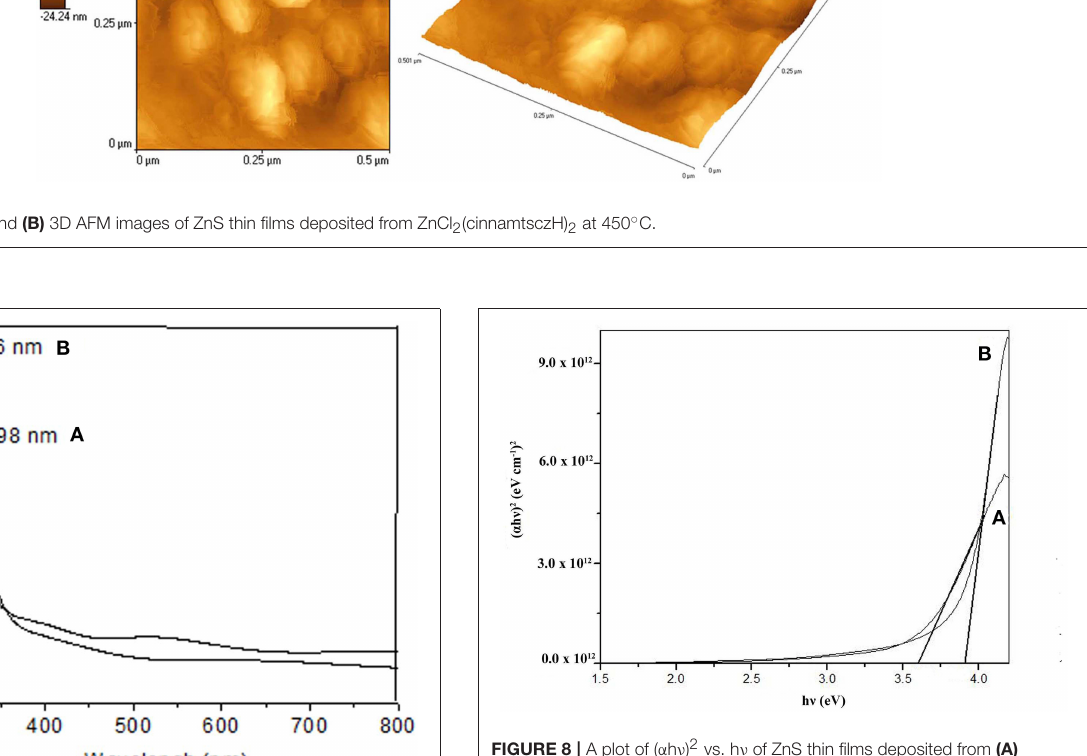
FIGURE 8 | A plot of ( α h ν ) 2 vs. h ν of ZnS thin films deposited from (A) Zn(cinnamtscz) 2 and (B) Zn(4-Clbenztscz) 2 at 450 ◦